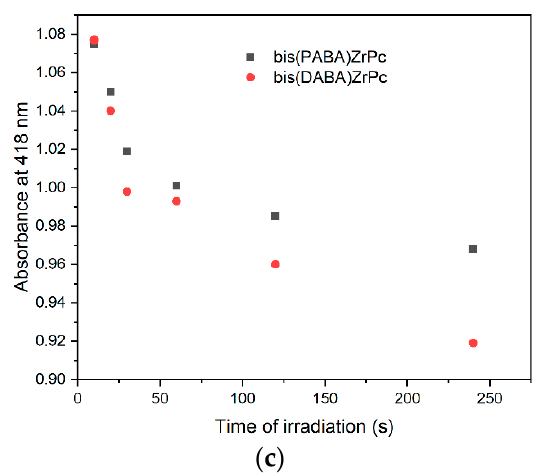
Figure 8. Absorption spectra of ( a ) bis (PABA) ZrPc/GO and ( b ) bis (DABA) ZrPc/GO suspensions before and after addition of 1,3-diphenylisobenzofuran showing DPBF bleaching when exposed to light irradiation. ( c ) Irradiation time dependence of DPBF absorbance in the presence of ZrPc/GO composites.